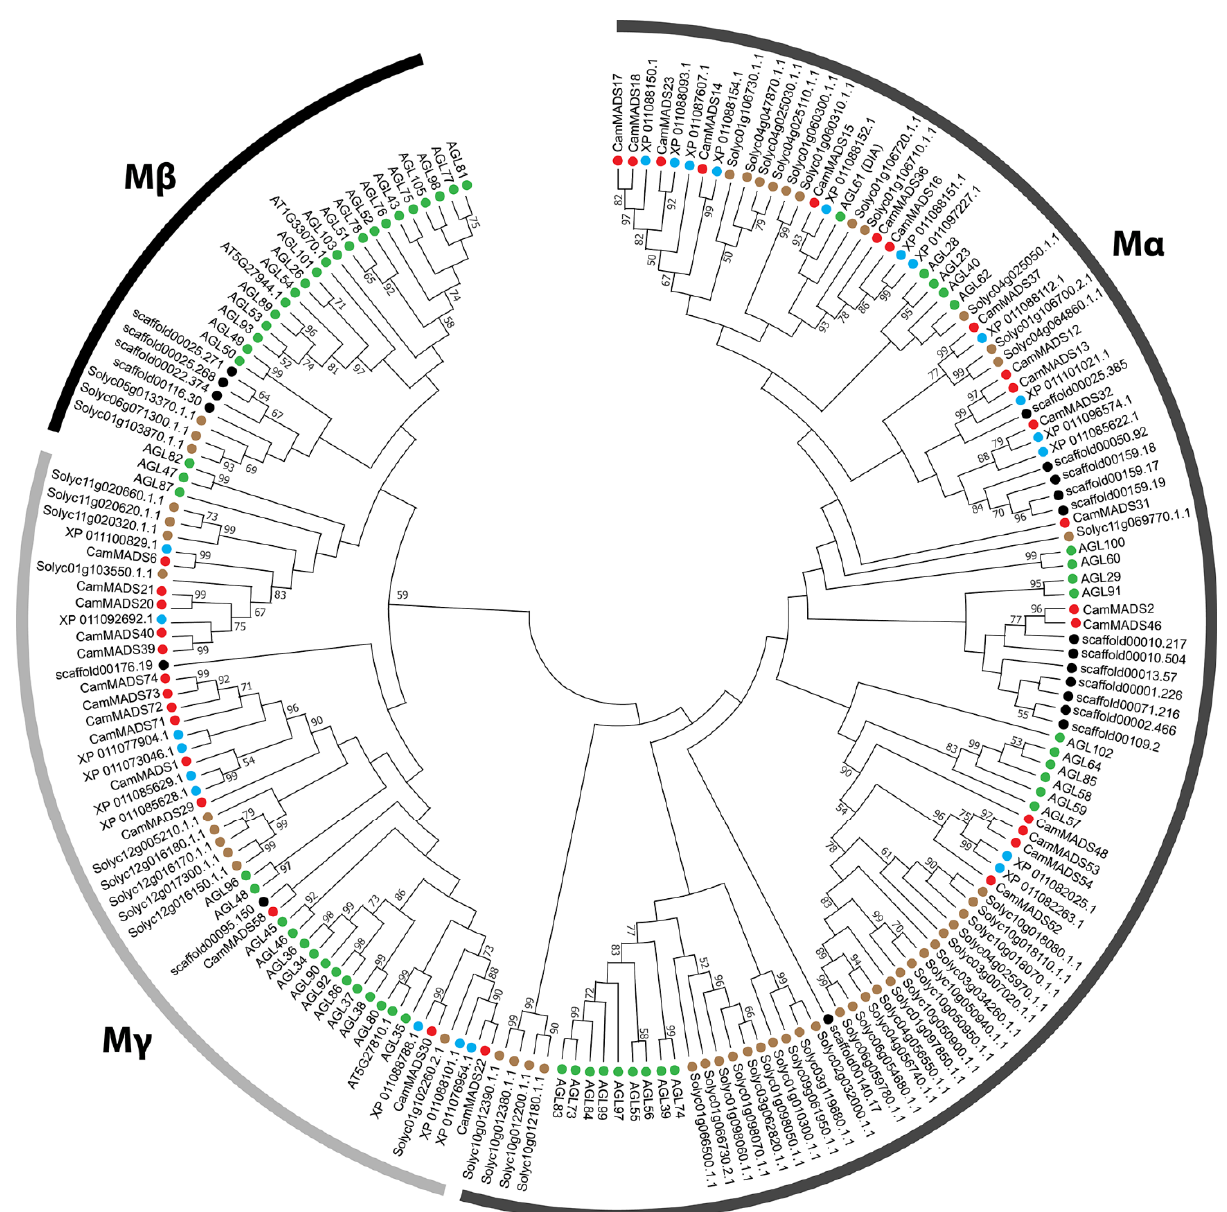
Figure 3. Maximum likelihood tree of type I MADS-box gene proteins in C. americana, A. thaliana, S. lycopersicum, S. indicum , and A. trichopoda . The MADS-box proteins contained in the branches for each species are indicated by different colored circles: red, C. americana ; green, A. thaliana ; brown, S. lycopersicum ; blue, S. indicum; black, A. trichopoda . For type I MADS-box proteins ML tree with branch length scale, see Supplementary Figure S1.